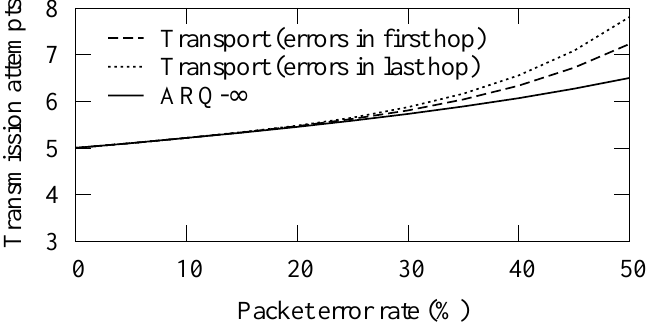
Figure 20. Complexity of different routing schemes with a route consisting of 5 hops. Only one hop is experiencing packet